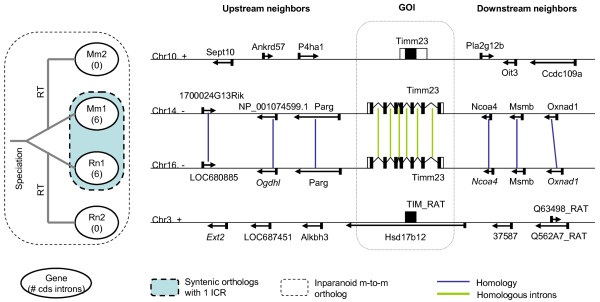
One example of many-to-many Inparanoid ortholog groups where RT events followed the mouse-rat speciation. The Ensembl gene IDs of GOI are ENSMUSG00000013701 (Mm1), ENSMUSG00000069622 (Mm2) and ENSRNOG00000019811 (Rn1), ENSRNOG00000032900 (Rn2). The gene structures and neighboring gene orders of four Timm23 genes in mouse and rat genomes are shown. The event tree on the left side is predicted based on the local synteny. RT: retrotransposition. Genes are shown corresponding to the strand of GOI in order to show the homology between neighboring genes. Homology between two neighboring genes are defined by Blastp E-value < 1e-5.